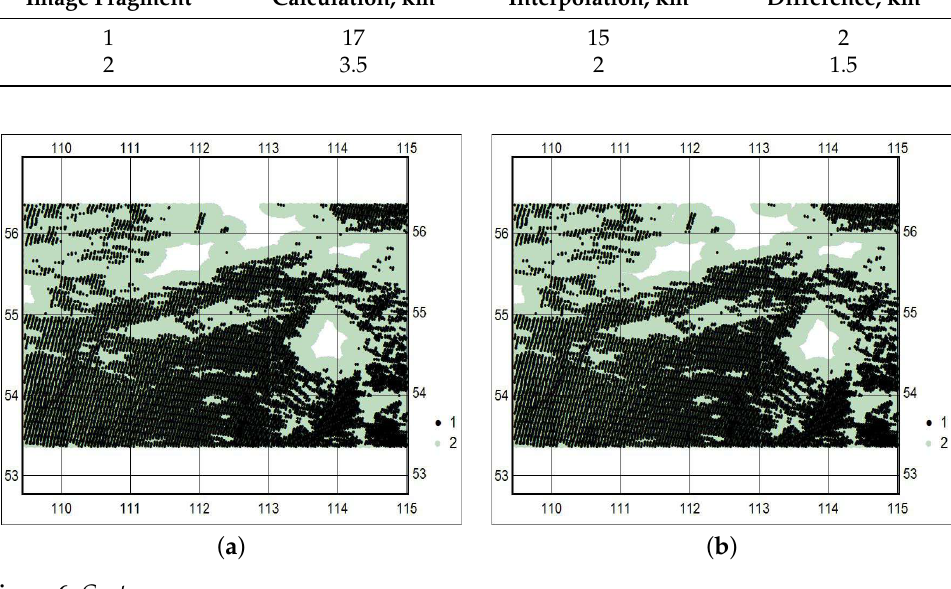
Table 2. Comparison of R ∗ values calculated and interpolated for two test image fragments. Image Fragment